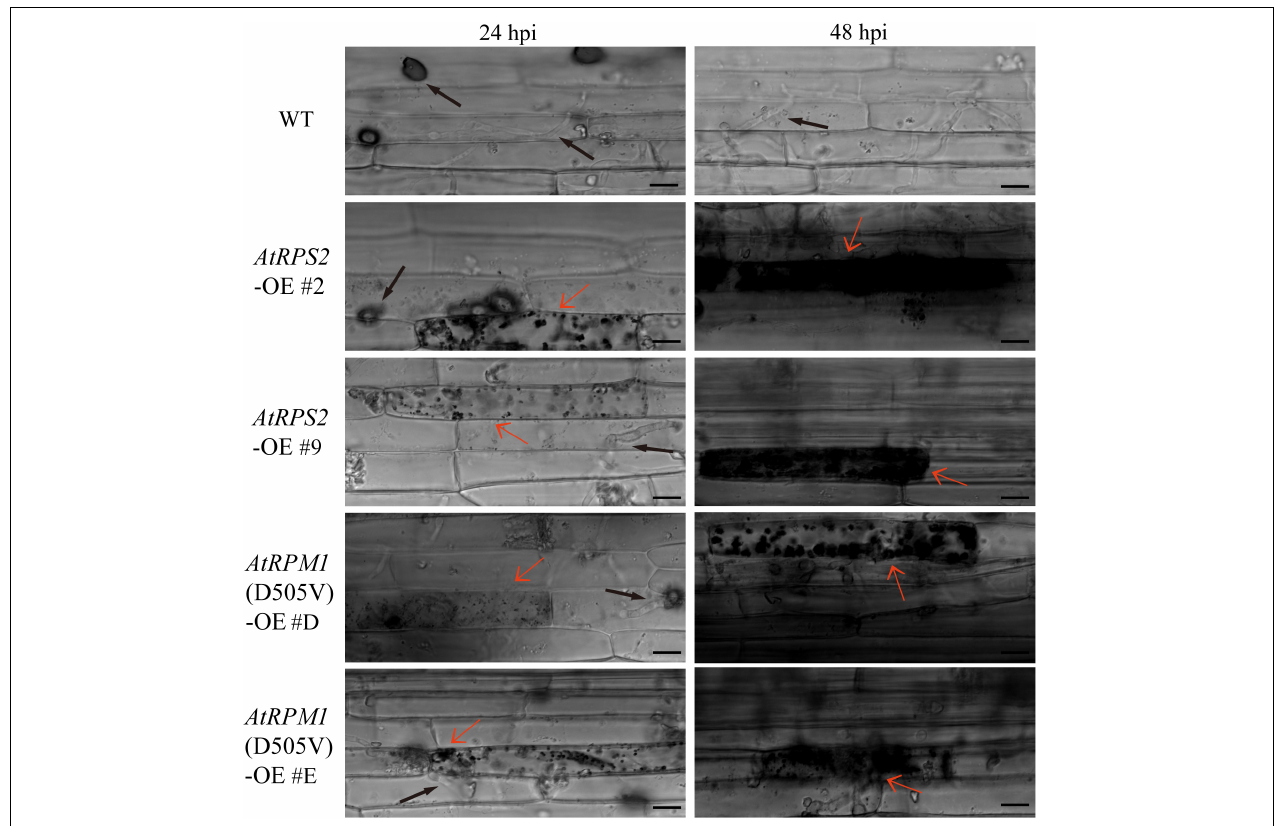
FIGURE 3 | AtRPS2 and AtRPM1 ( D505V ) Restrict M. oryzae Invasion in Transgenic Plants. Representative microscopic images showing the growth of the M . oryzae isolate GC1-4 at 24 and 48 hpi on the sheath cells of the transgenic plants and Nipponbare. Black arrows indicate the appressorium and invasive hyphae, and red arrows indicate the plant cell death. Scale bars = 20 µ